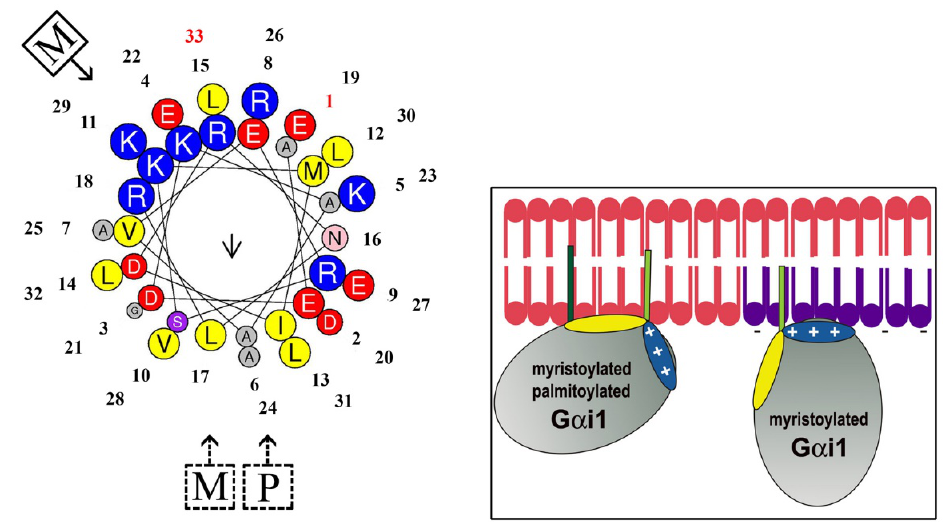
Figure 5. Effect of palmitoylation on Gαi1 - membrane interactions. Gαi1 protein has N -terminal myristoyl (M) and palmitoyl (P) moieties. Whereas M is an irreversible lipidation, P can be enzymatically added or removed upon signaling control. Myristoylated-depalmitoylated G protein interacts with negatively charged membrane areas because the lipid anchor favors the exposure of positively charged amino acids to the membrane interface (M with arrow). Palmitoylation induces a twist in the N- terminal α - helix of Gαi1 protein that causes exposure of uncharged amino acids to the bilayer surface (P with arrow and M with arrow). This in part explains the ability of Gαi1 protein to have different lipid-protein-protein-lipid (LPPL) interactions, in which the configuration Lx-PG-Py-Ly (where G would be Gαi1) indicates that the transducer would interact with different lipids (Lx could be phosphatidylserine or another membrane lipid according to the palmitoylation status) and Py could be a G protein-coupled receptor (GPCR) or an effector protein (adenylyl cyclase). It has to be kept in mind that the Gβγ dimer also participates in these LPPL interactions [17]. Adapted from [58].